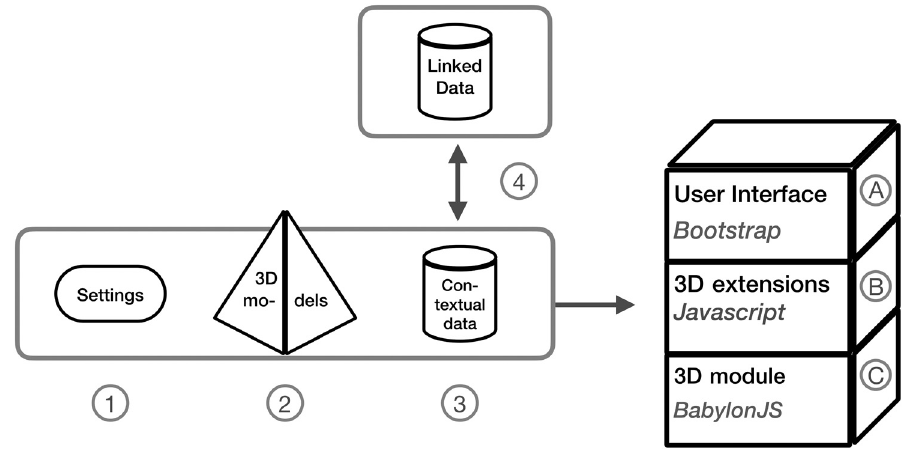
Figure 12: Diagram with application structure for the 3D research environment, consisting of the application itself ( A – C ) , and resources which are loaded by the application ( 1 – 4 )